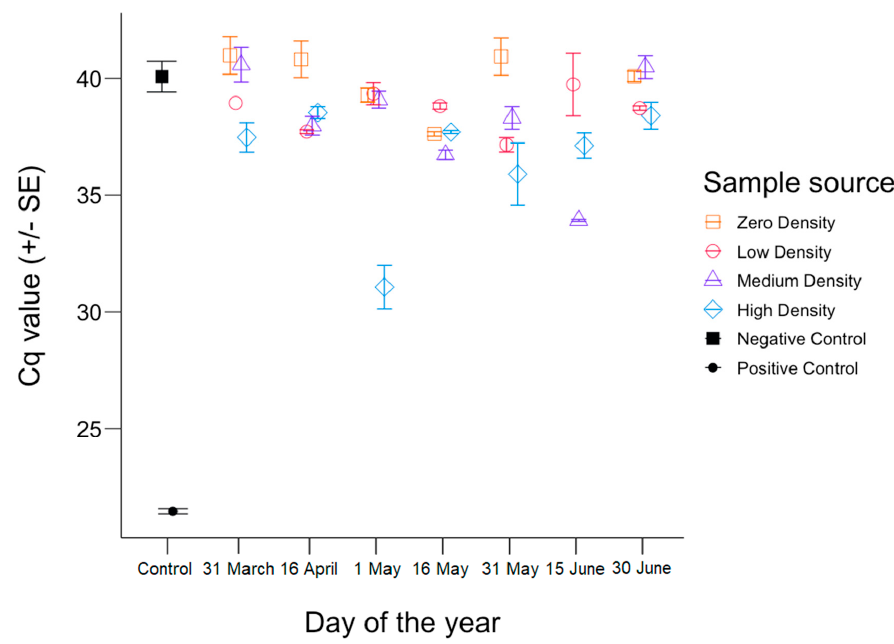
Figure 2. Amplification (quantification cycle = Cq) of adult painted turtle eDNA as a function of sample source and date. Higher Cq values indicate less eDNA. Varying colors and symbols represent pond treatments: the zero-density pond had 0 turtles (orange squares), the low-density pond had 11 turtles (red circles), the medium-density pond had 23 turtles (purple triangles), and the high-density pond had 38 turtles (blue diamonds). Points indicate the average triplicate value of each sample and points are jittered for readability. The positive controls from extracted painted turtle blood and the negative controls were plotted at the left column to facilitate comparisons. The zero-density pond on 15 June failed to amplify, and only one replicate of the low-density pond on 31 March amplified.